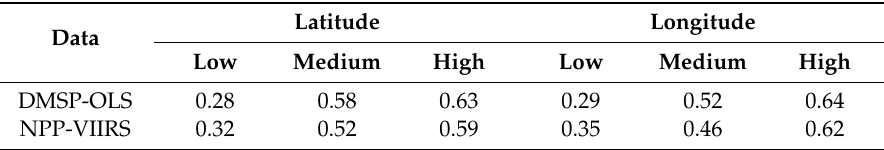
Table 3. The R 2 of TNL-CO 2 regression in different geographical